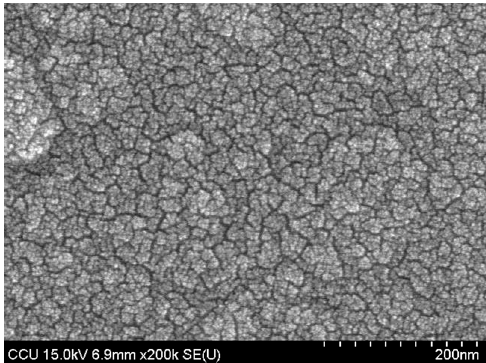
Figure 3. The surface morphology of NiO film.